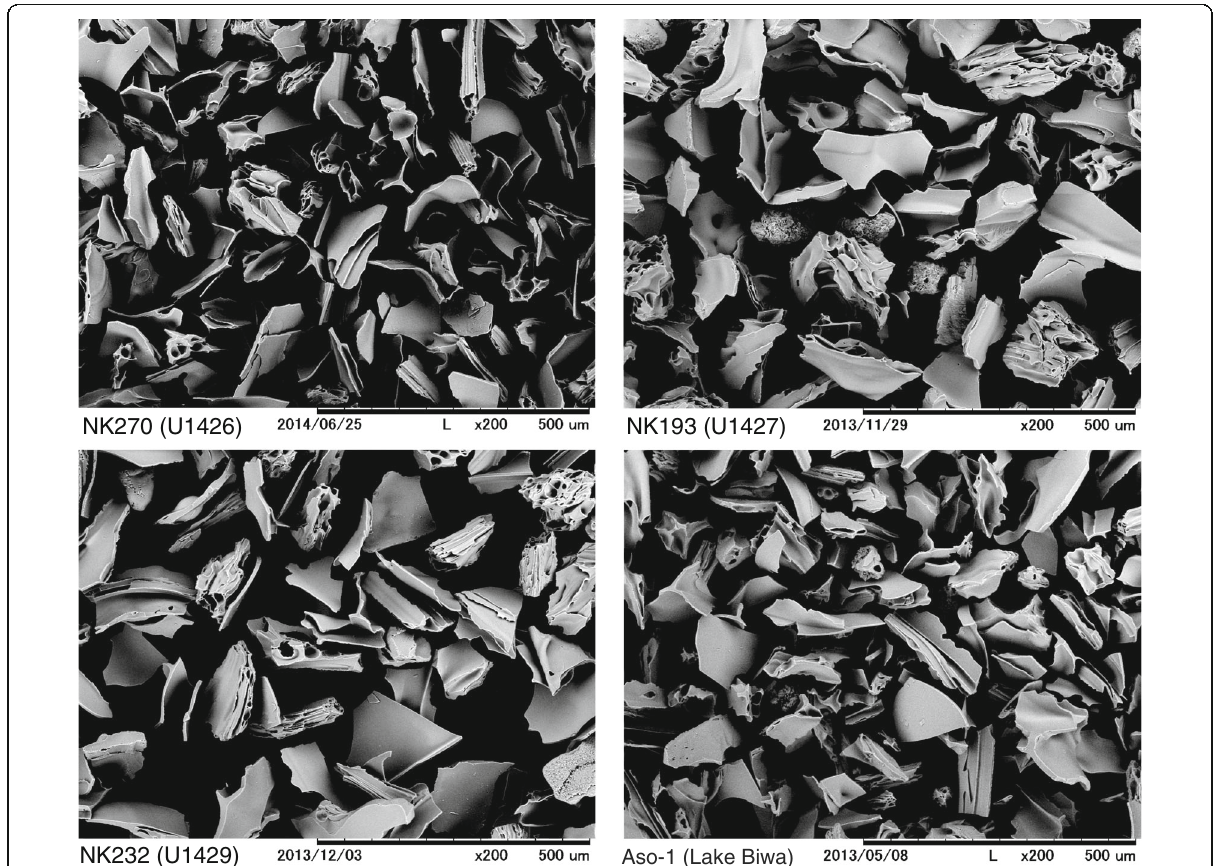
Fig. 4 Scanning electron images of volcanic glass shards of the Aso-1 tephra at Sites U1426, U1427, U1429, and Lake